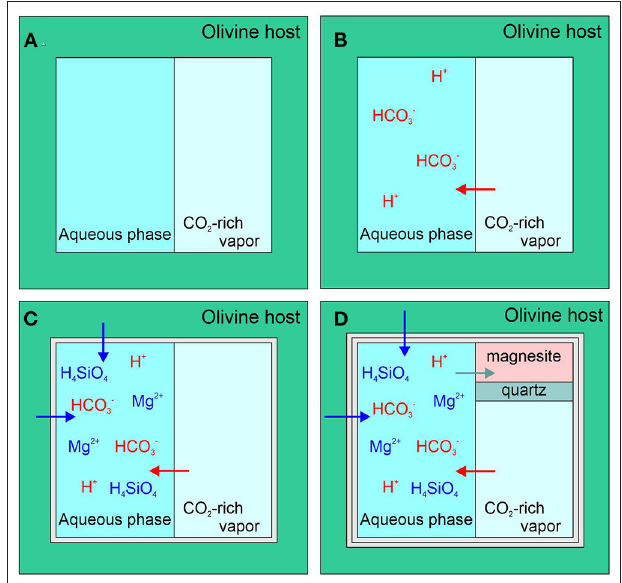
FIGURE 2 | Conceptual model showing the sequential steps involved in the carbonation of olivine using synthetic fluid inclusions. (A) Initially the fluid inclusion contains an aqueous phase and a CO 2 -rich vapor phase; (B) Dissolution of CO 2 into the aqueous phase occurs through the formation of various carbonated aqueous species; (C) The aqueous phase interacts with the olivine host, leading to dissolution of olivine from the inclusion walls, and; (D) Olivine dissolution leads to saturation and precipitation of magnesite and quartz (or amorphous silica), while at the same time transferring CO 2 from the vapor phase into the solid (magnesite).